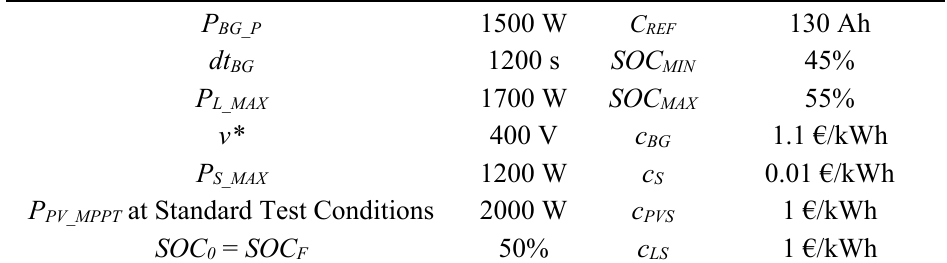
Table 1. Optimization and experimental parameters values.